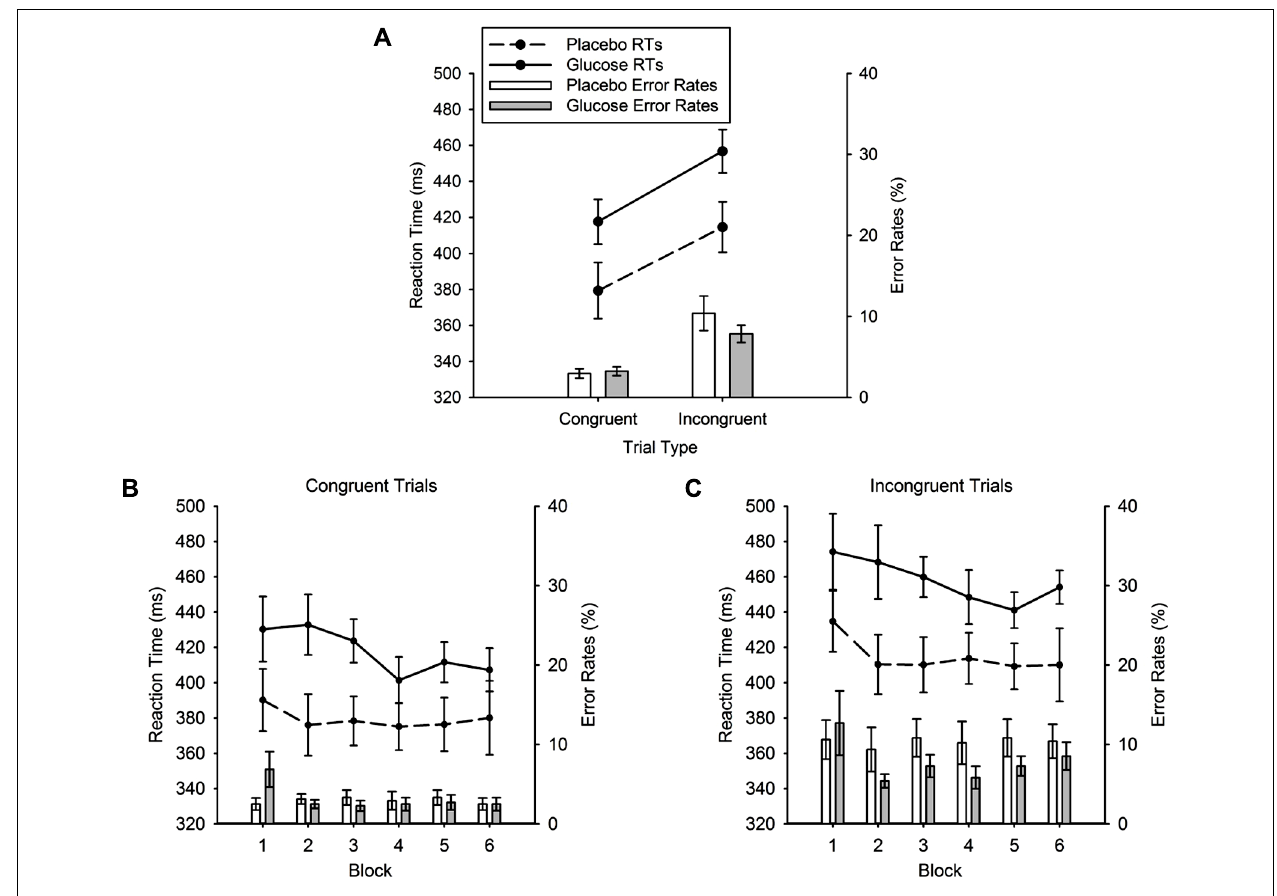
FIGURE 6 | (A) Mean reaction times (lines) and error rates (bars) for the congruent and incongruent conditions of the flanker task for glucose (solid lines; gray bars) and placebo (dashed lines, white bars). (B) Mean reaction times (lines) and error rates (bars) in the